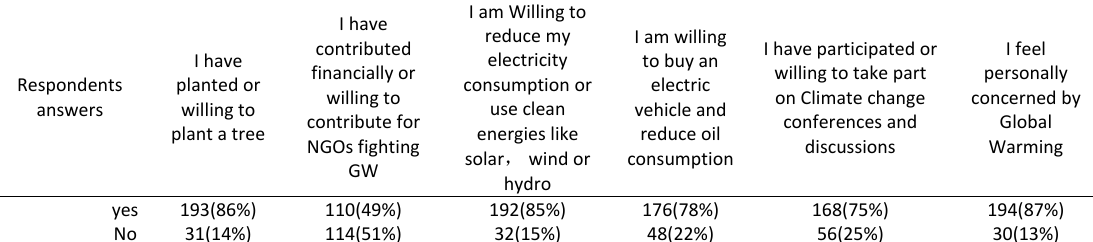
Table 5: Willingness and involvement on GW issue